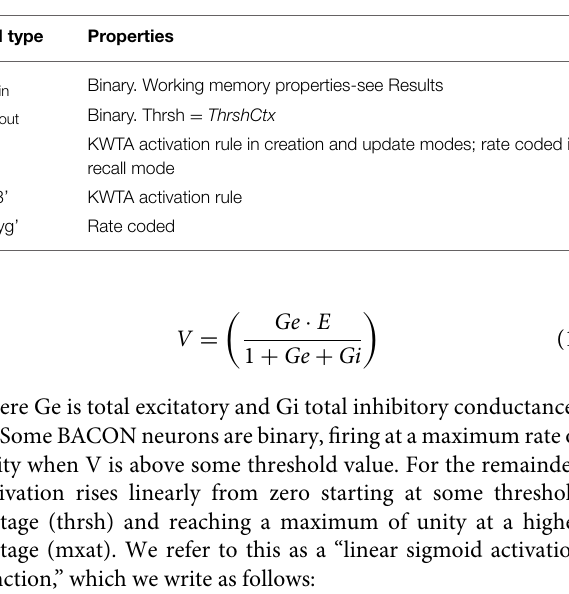
FIGURE 1 | Cortex-hippocampus-amygdala circuit (A) basic circuit. Explained in text. Pink synapses subject to LTP in appropriate modes. Circular arrows in EC’ in cells indicate working memory properties. (B)